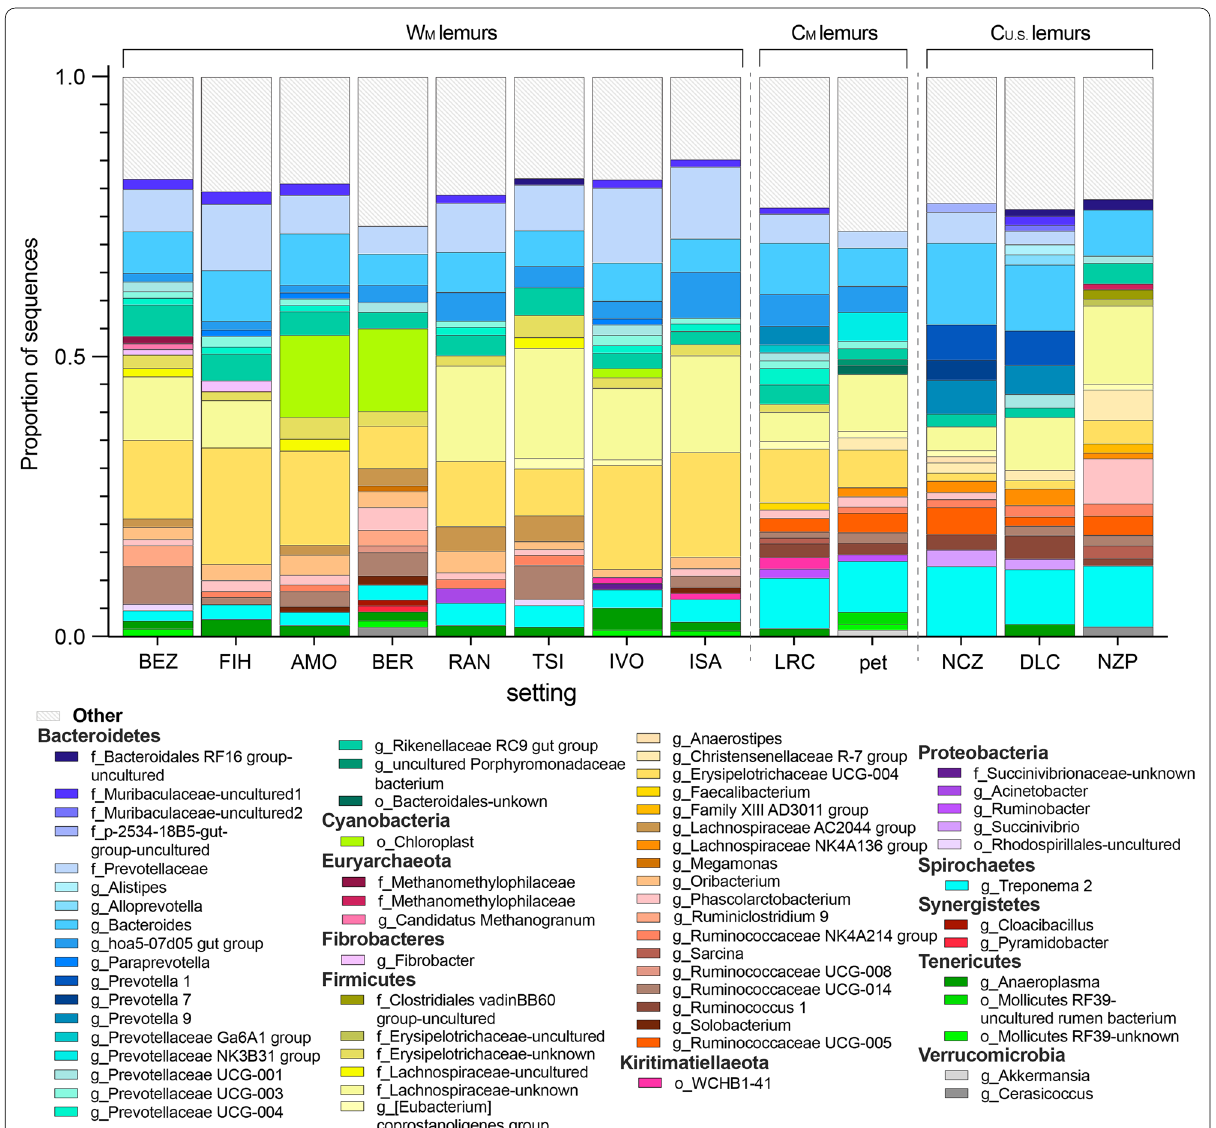
Fig. 2 Mean proportion of sequences assigned to microbial taxa across lemurs at each of the 13 different settings, with the three environmental conditions (wilderness, W M ; captivity in Madagascar, C M ; and captivity in the U.S., C U.S. ) delineated by dashed vertical lines (see Table 1 for names of abbreviated study settings). Taxa are identified by phylum and deepest possible taxonomic level (i.e., genus level or above); those representing < 1% of the microbiomes were combined into the category